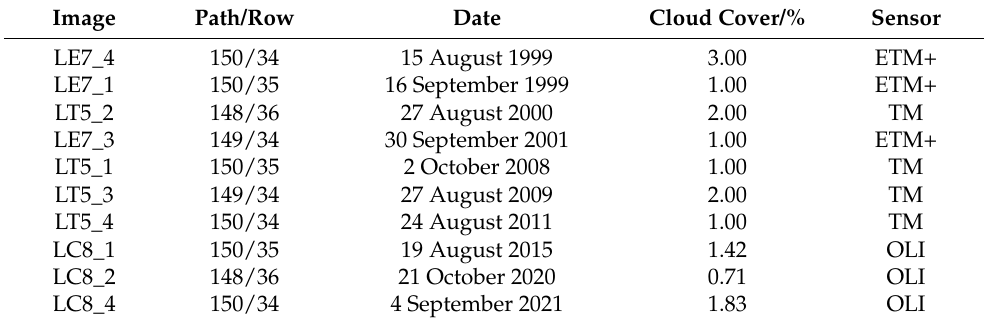
Table 1. The information of remote sensing